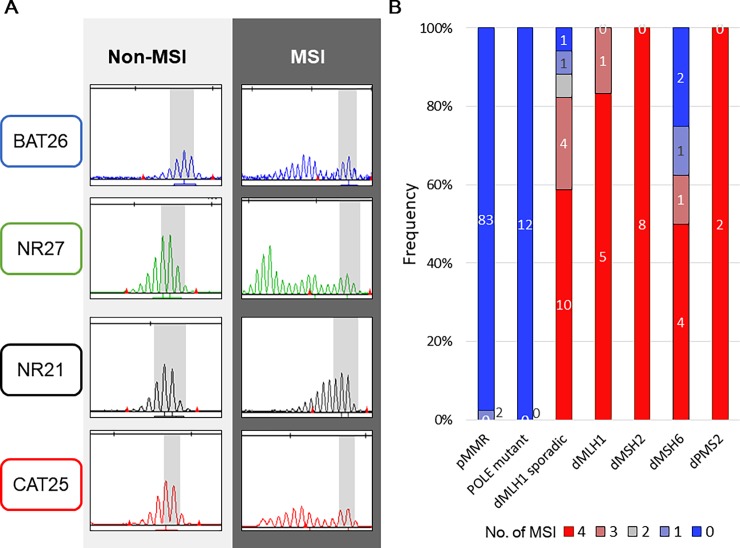
Detection of MSI and distribution of number of MSIs in 138 EC patients.(A) Example of MSI and non-MSI cases analyzed by four mononucleotide repeat markers (BAT26, NR21, NR27, and CAT25). (B) Association between MSI, POLE mutation, MLH-1 promoter methylation and MMR protein expression. The number of mononucleotide repeat markers showing MSI are shown by color.